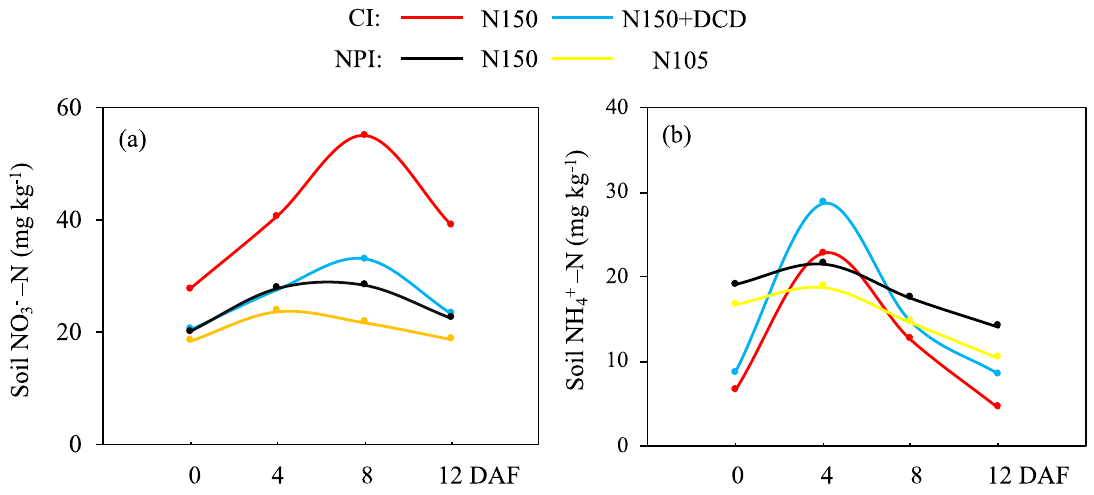
Figure 3. Dynamic changes in soil NO 3 − –N and NH 4+ –N contents under different irrigation and N treatments. ( a ) Soil NO 3 − –N; ( b ) Soil NH 4+ –N. CI is conventional irrigation, and NPI is negative pressure irrigation. N150: 150 kg N ha − 1 , N105: 105 kg N ha − 1 ; DCD is DCD addition. All of the data are the means of three replicates. DAF is the day after fertilization.